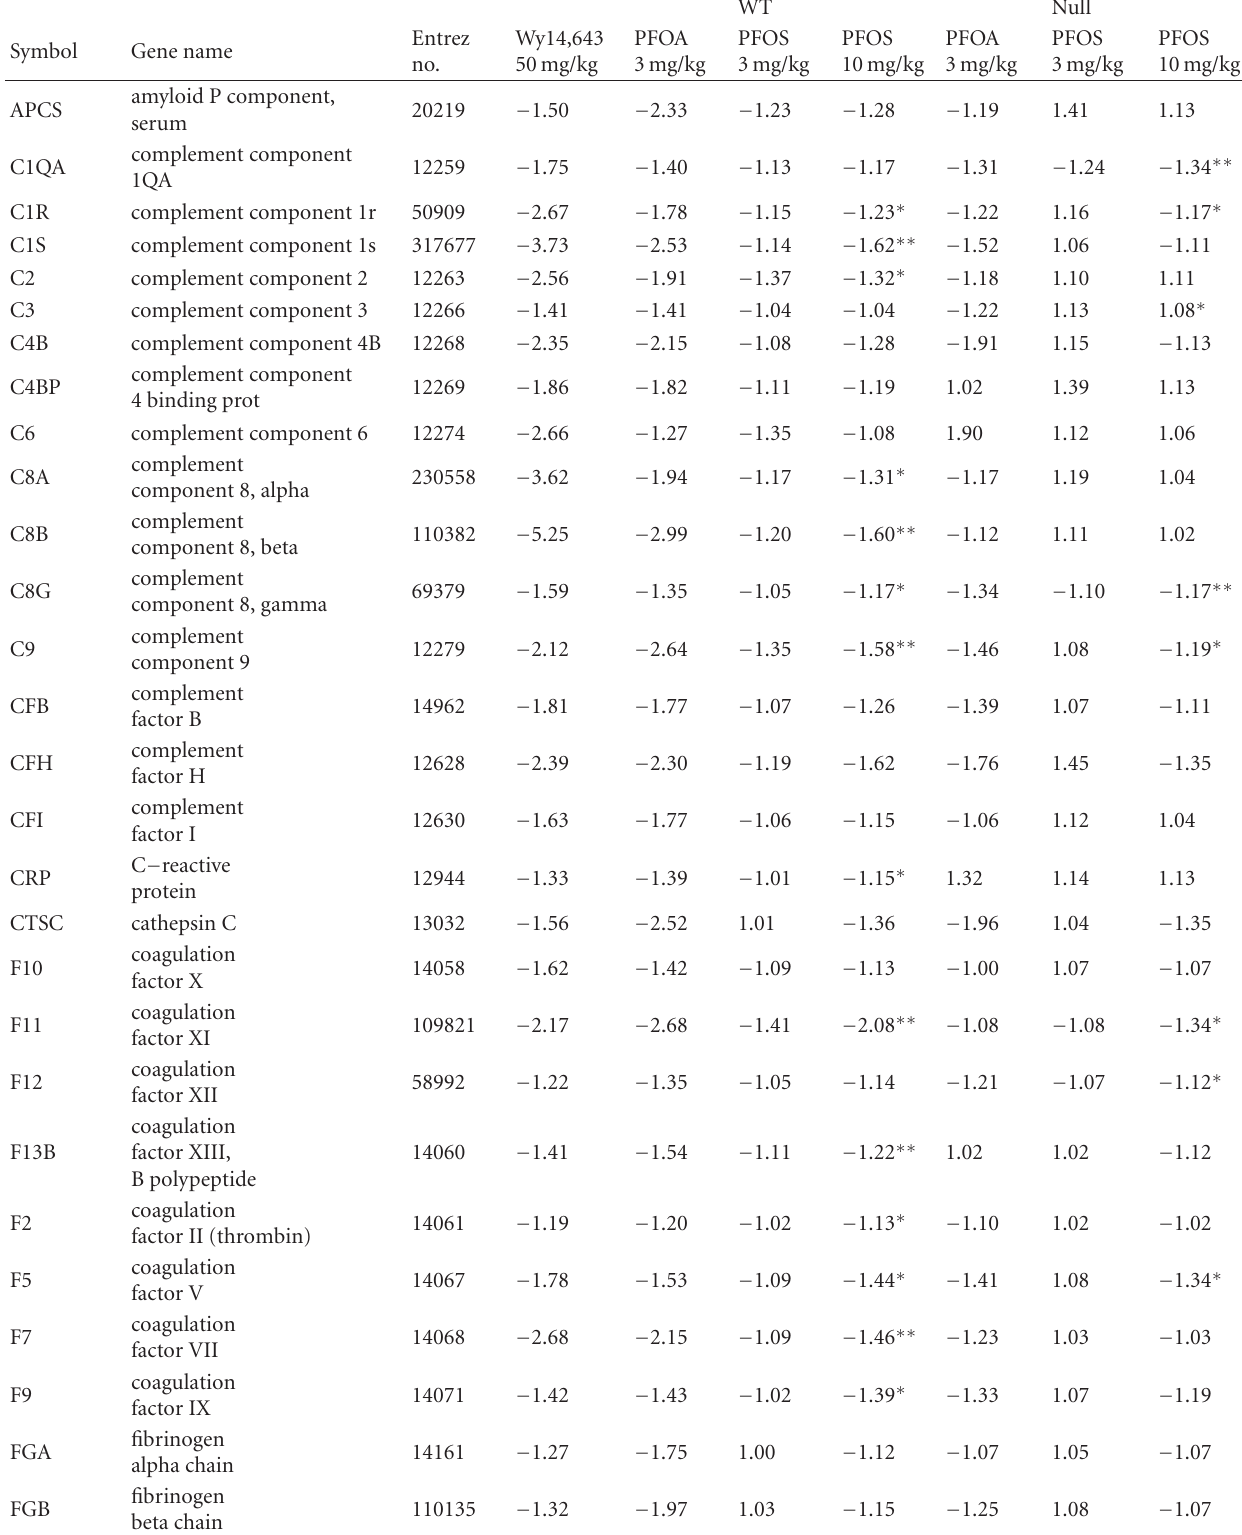
Table 6: Average fold change for genes related to the inflammatory response in wild-type and PPAR α -null male mice following a seven-day exposure to Wy-14,643 1 , PFOA 1 , or